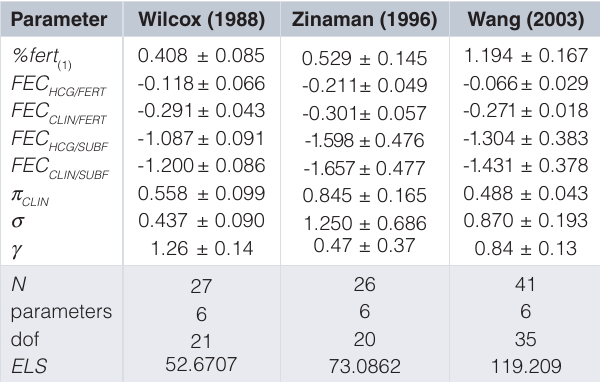
statistically identical models were used to obtain standard errors for